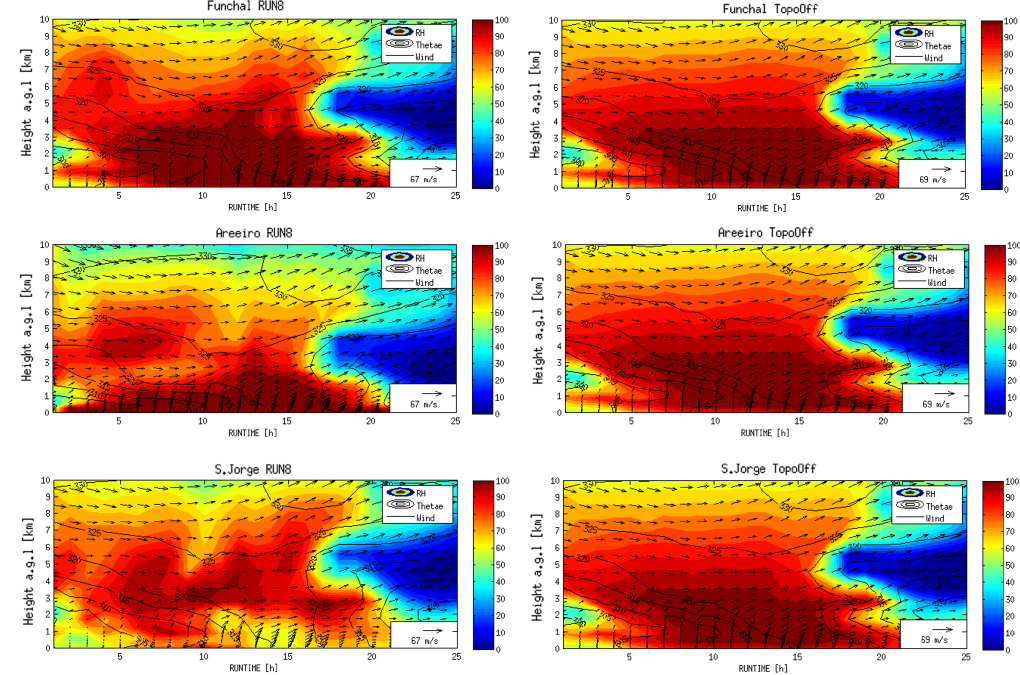
Fig. 11. Time evolution of equivalent potential temperature, relative humidity and horizontal wind over Funchal (windward), Areeiro (crest) and S. Jorge (lee side).